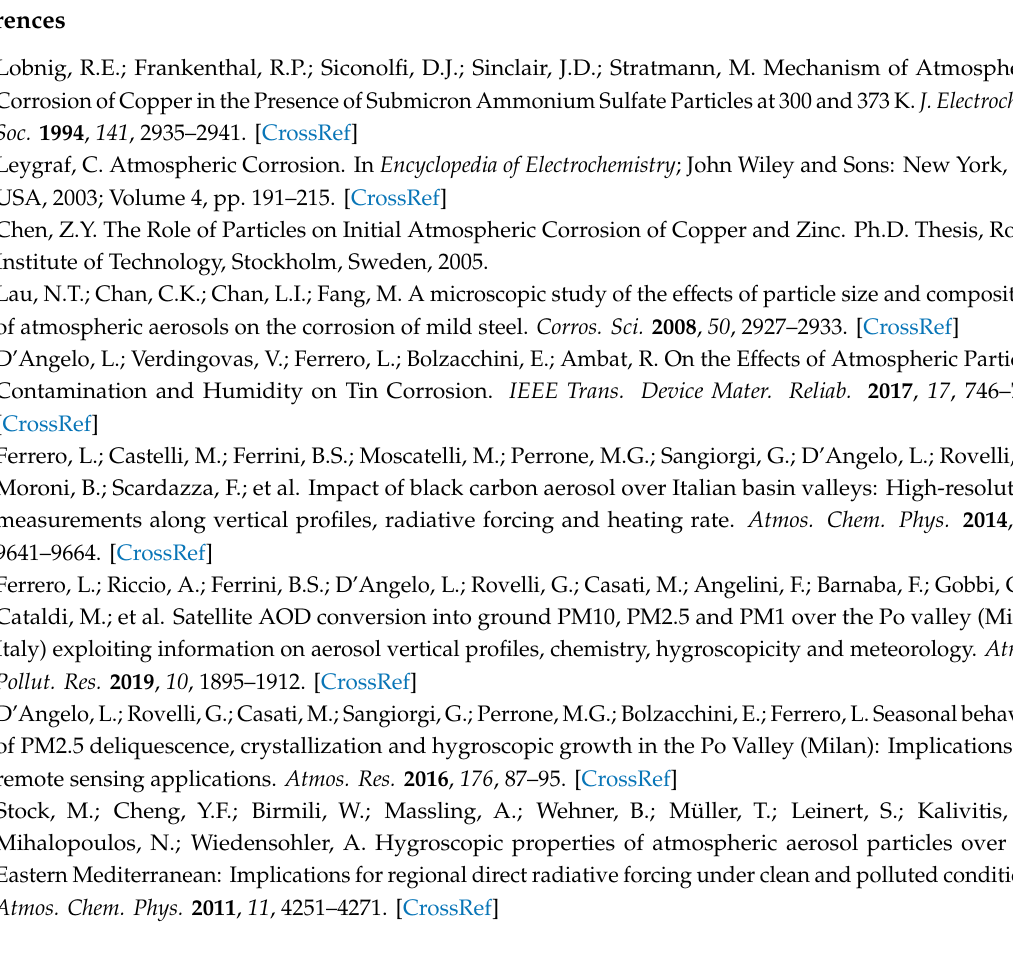
Figure S1: Guillotine cutter for filters, Figure S2: Conductance and RH equilibration (steps of 30 min) within the AEC on a PM2.5 sample, Figure S3: Conductance for each RH steps at 0 s, 180 s, 1200 s and 1800 s for the sample showed in Figure S1, Figure S4: Conductance cycles repeated two times on the same PM2.5 sample, Figure S5: Normalized number size distribution of genetared salts, WI-mix, SU-mix and soot particles, Figure S6: Active sampling spot size of a PTFE filter, Figure S7: Stereomicroscope image (Leica Wild M420, 64x enlargement) for a PM2.5 MI-TS ambient sample, Figure S8: Correlation between tha conductance value at the DRH overcoming with the product (i.e. synergic e ff ect) between the number of equivalent of inorganic ions and the mass of EC on filters both ambient (panel a) and laboratory generated (panel b). Note that the mass of EC cannot be transformed into moles as EC is not a well-defined molecule characterized by its own molecular weight, Table S1: Raw data of PM2.5 ambient samples with sampling location (from Milano Torre Sarca, MI-TS, and Oasi Bine, OB), season, date, mass loading, surface spot size, electrical detection (DET*), electrode distance (ED*), conductance (maximum detected value, G*) and chemical data, Table S2: Raw data of laboratory generated PM samples with generation chemistry, mass loading, surface spot size, electrical detection (DET*), electrode distance (ED*), conductance (maximum detected value,